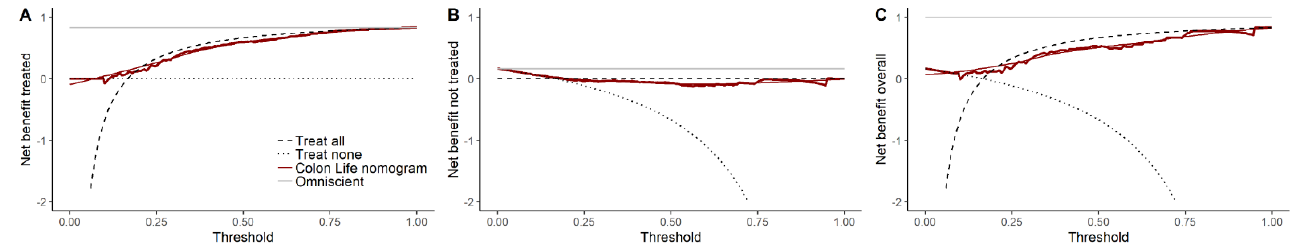
Figure 3. Decision curve analysis indicating the net benefit when using Colon Life nomogram- informed decision making for FTD/TPI treatment. Decision curves based on the net benefit for the treated ( A ), the net benefit for the untreated ( B ), and the overall net benefit ( C ) are shown for informing clinical decision-making regarding FTD/TPI treatment using predicted 12-week mortality risk estimated by the Colon Life nomogram. The net benefit for patients is compared across 3 sce- nario’s: non-informed decision-making, by treating all patients (“treat all”) or treating no patients (“treat none”), and informed decision-making, by treating patients according to the models’ predicted 12-week mortality risk for a given range of thresholds (“Colon Life nomogram”, thick red line is the Loess smoothed line and the thin red line is the non-smoothed line). The “Omniscient” line indicates the line for a hypothetical all-knowing model. The overall benefit is the sum of the net benefit for the treated and untreated patients. The thresholds shown represent values for 12-week mortality rate. Patients receiving FTD/TPI treatment benefit if the predicted 12-week survival probability is above the threshold value and the patient did not die within 12 weeks (versus harm if they did). Similarly the net benefit for not receiving FTD/TPI is analyzed, where patients benefit if the predicted 12-week survival probability is below the threshold value and the patient did die within 12 weeks (versus harm if they did not). Abbreviations: FTD/TPI